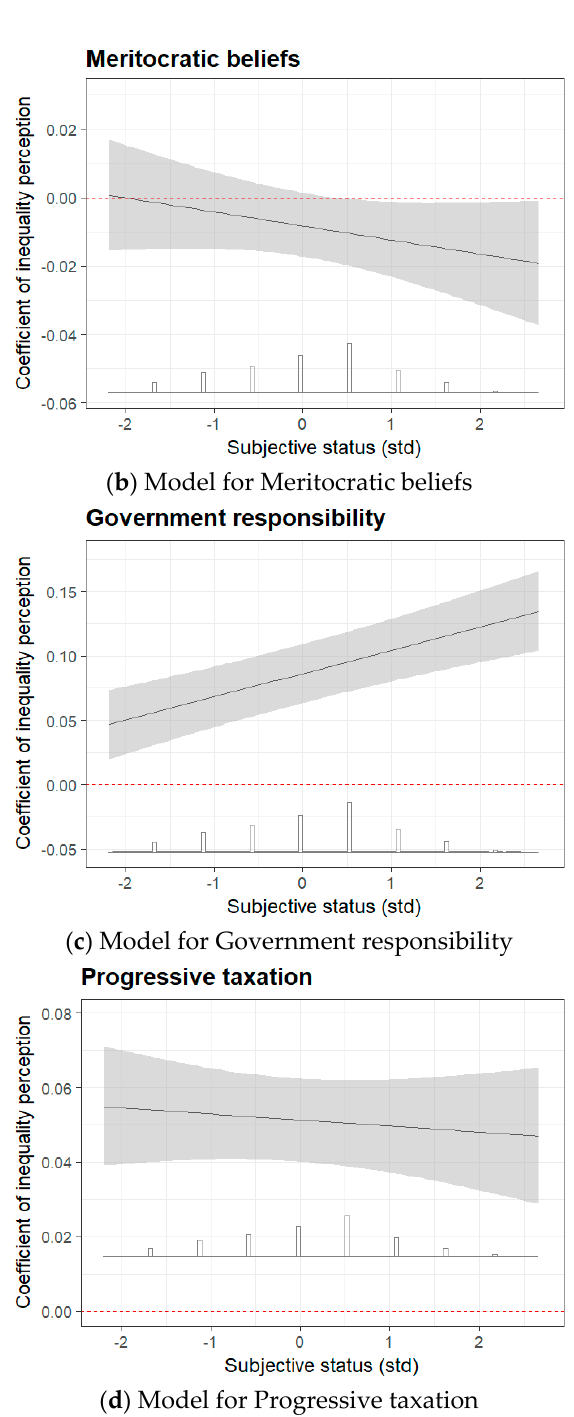
Figure 3. Marginal coefficients of inequality perception conditional on perceived social status for inequality preference ( a ), meritocratic beliefs ( b ), government responsibility ( c ), and progressive taxation ( d ).